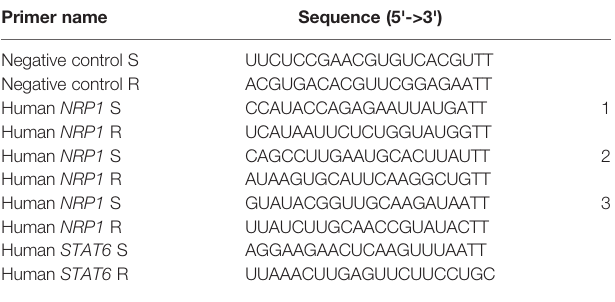
TABLE 1 | Sequences of siRNA used in this